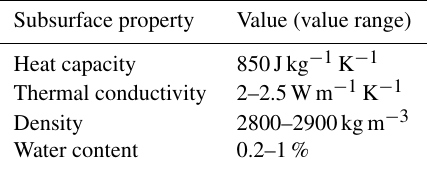
Table 1. Values for subsurface properties as used in the stationary three-dimensional transient heat conduction